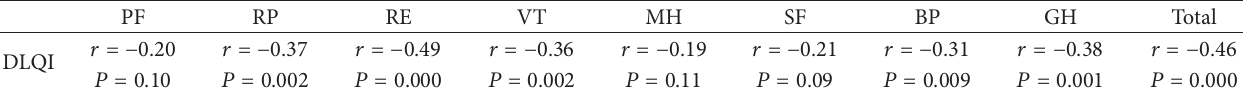
Table 4: Pearson correlation between the scores of different domains of QOL obtained from the two questionnaires (SF-36 and DLQI) in patients with acne vulgaris.